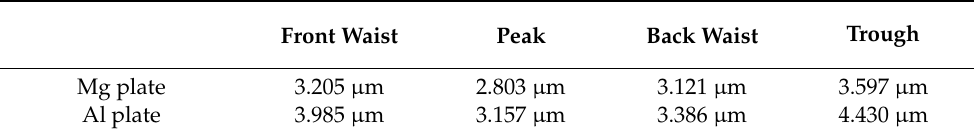
Table 3. Surface roughness of interface Mg plate and Al plate of the corrugated clad plate.